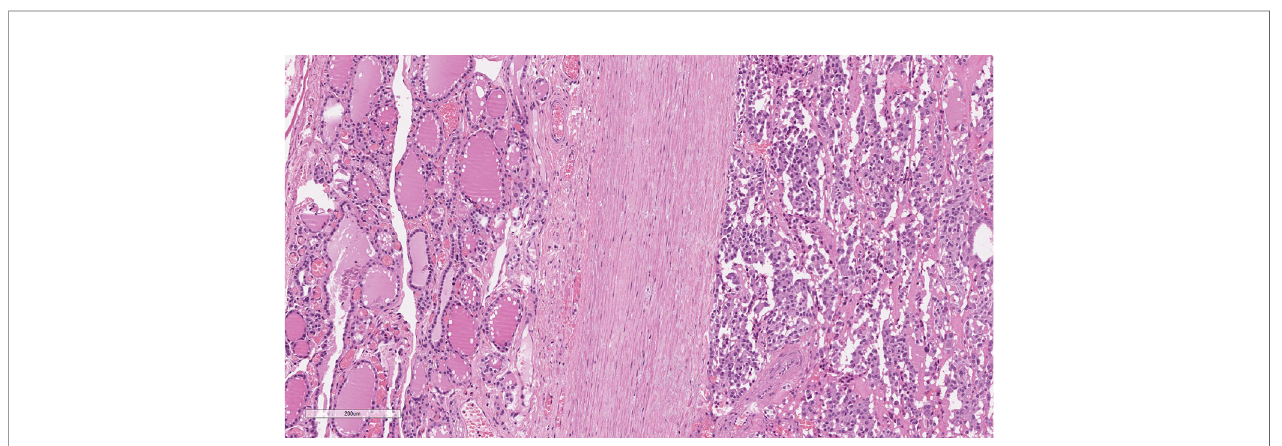
FIGURE 1 | Medullary thyroid carcinoma showing a tumor capsule. The neoplastic cells (right) are demarcated from the normal thyroid parenchima (left) by a fi brous capsule (center). (Hematoxylin and eosin, original magni fi cation 10x).